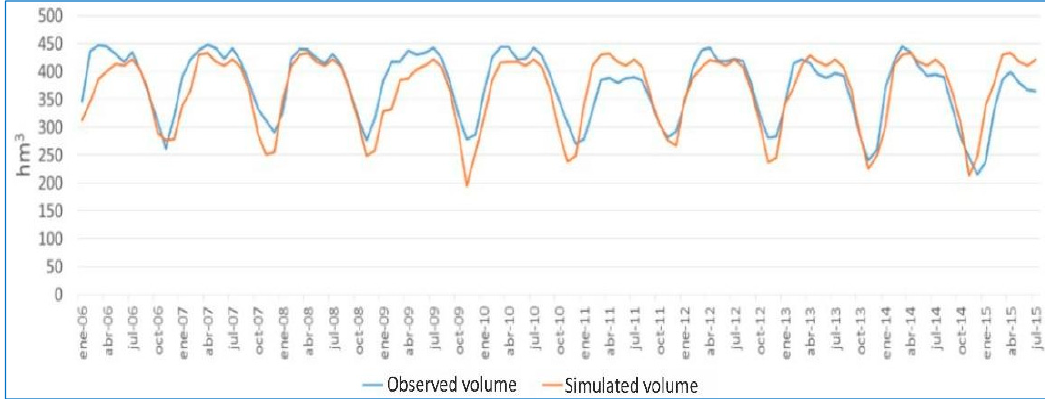
Table 3. Averages spills at Potrerillos Dam, 2006 – 2015.